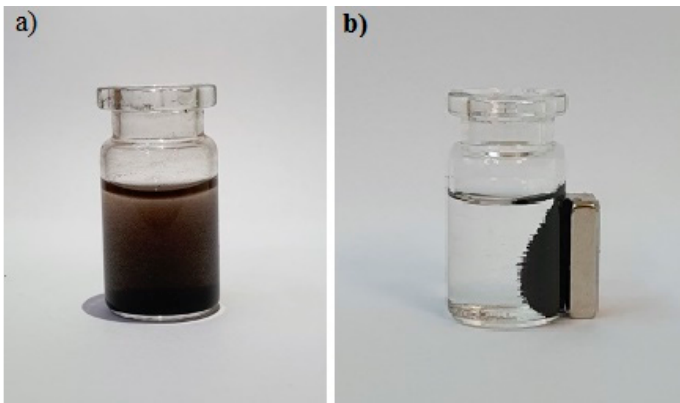
Figure 7. Magnetic nanoparticles after binding ketoprofen with HSA: ( a ) before applying the magnet; and ( b ) after applying the magnet.